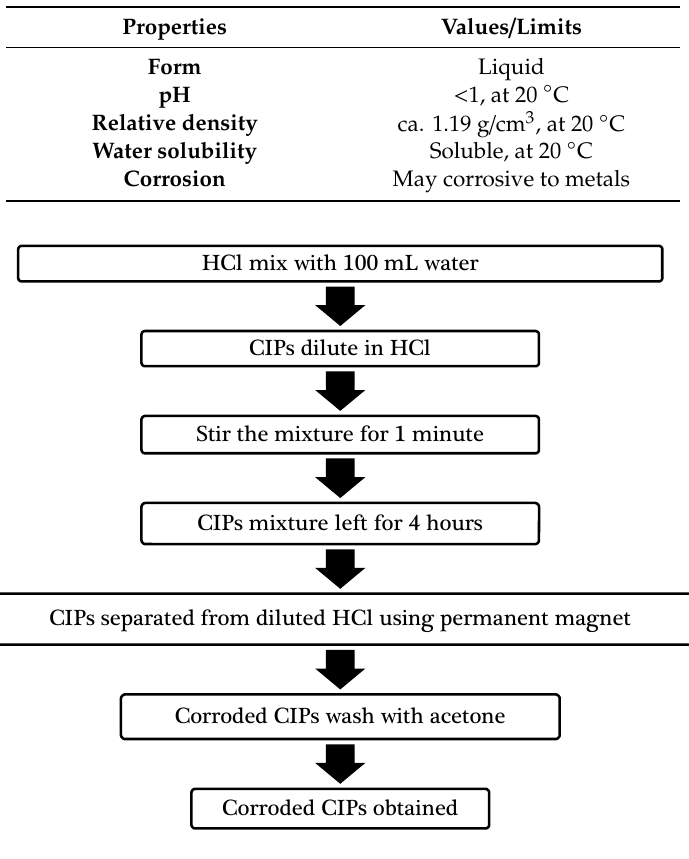
Figure 14. Schematic diagram of the corrosion process of CIPs.